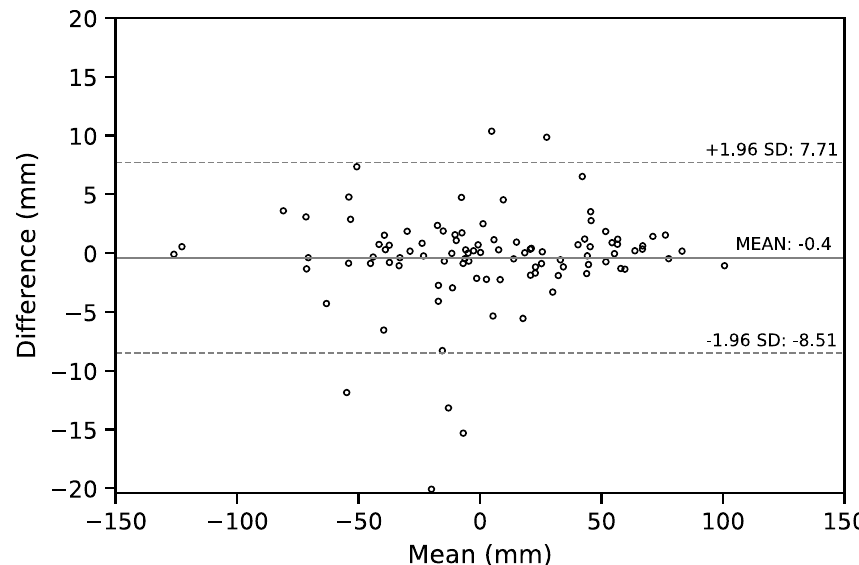
Figure 9. The Bland–Altman plot for the SVA values estimated by the senior and the junior resident orthopedic surgeons. The horizontal lines of mean difference (solid line) and mean difference ± 1.96 standard deviation (SD) are plotted (dashed lines).